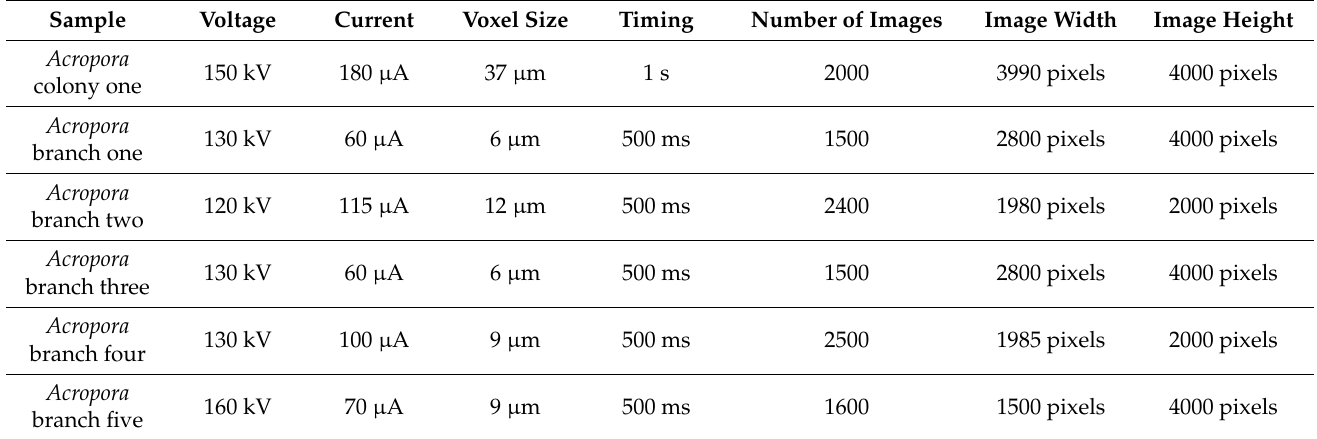
Table 1. Parameters of the HRCT